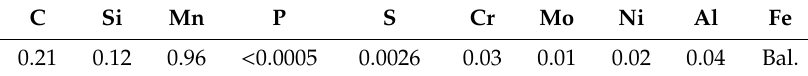
Table 1. Chemical composition of the Q345.